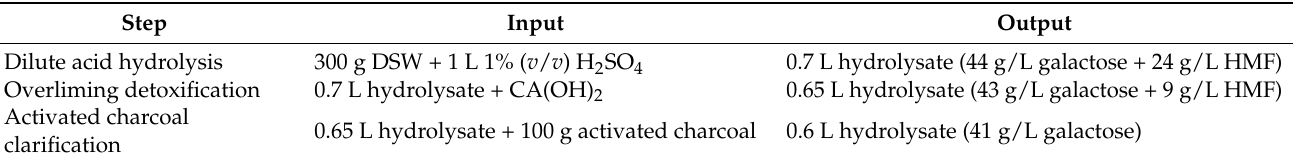
Table 3. Input and output of K. alvarezii